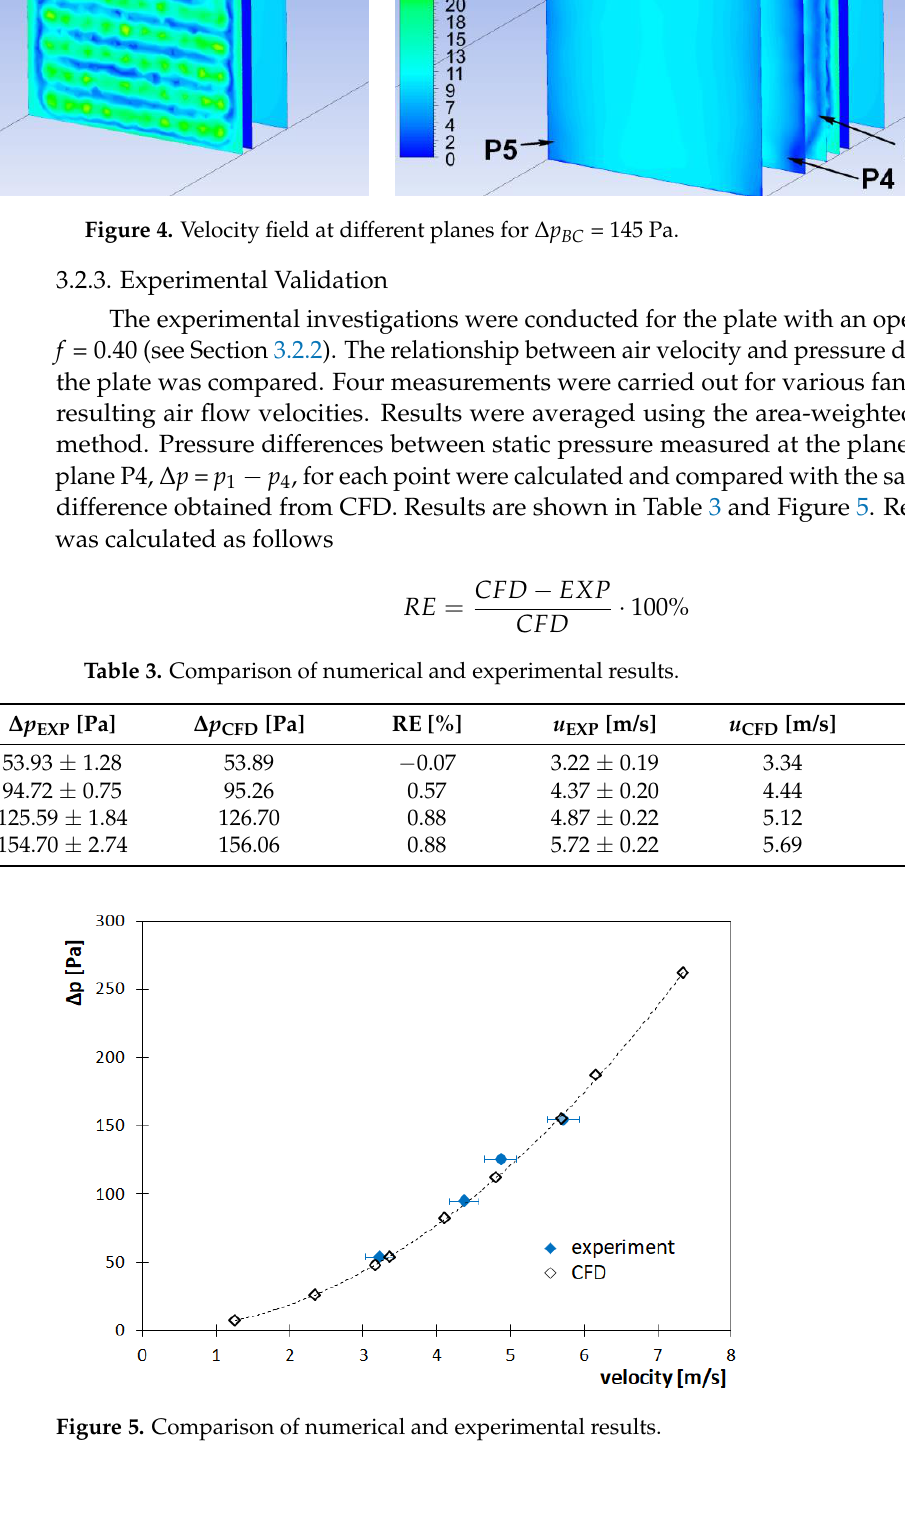
Figure 4. Velocity field at different planes for Δ p BC = 145 Pa.